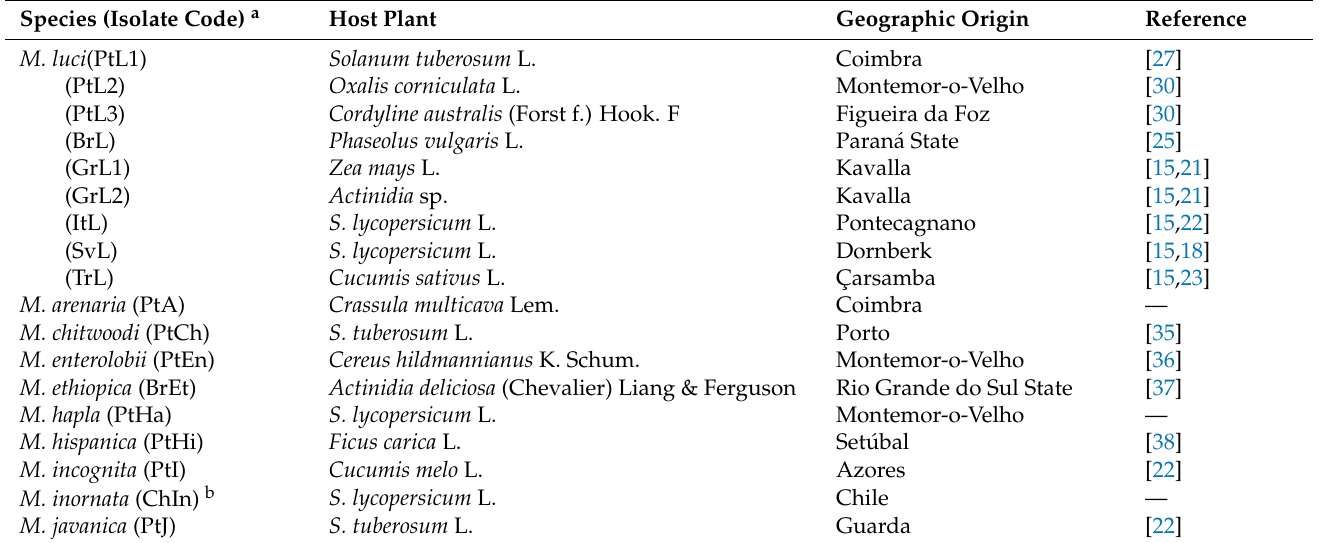
Table 1. Meloidogyne isolates: hosts and geographic